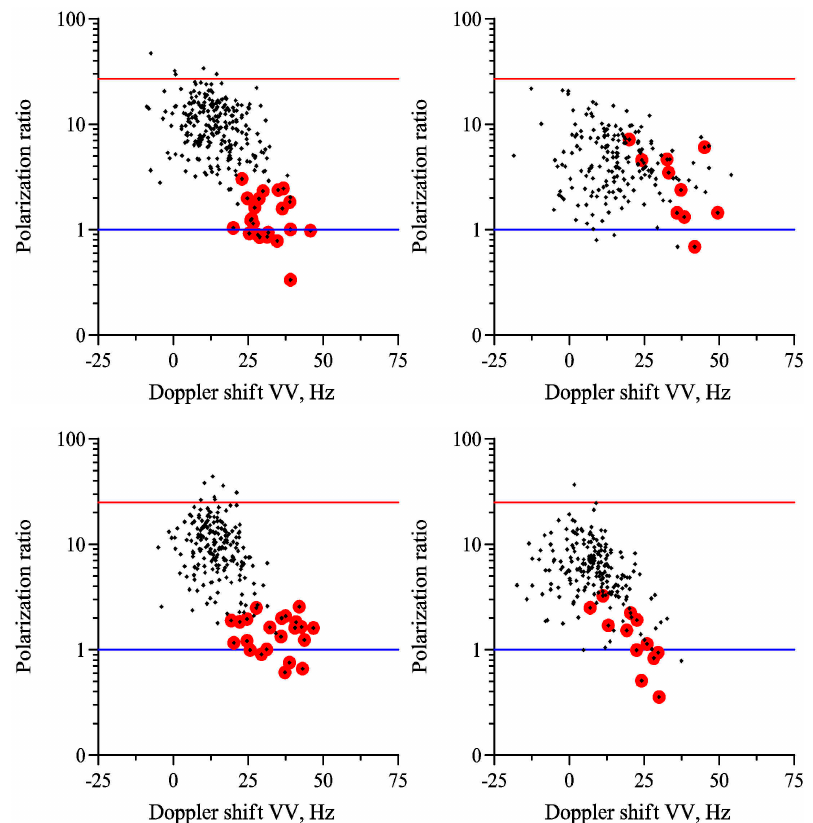
Figure 12. Instantaneous PR-values vs. Doppler shift at VV-polarization for clean water ( left ) and in slick ( right ). Red lines are PR-values in Bragg theory, blue line (PR = 1) corresponds to the case of completely non polarized radar return. Incidence angle 60°, wind velocity of 10 m/s ( top ) and 7 m/s ( bottom ).